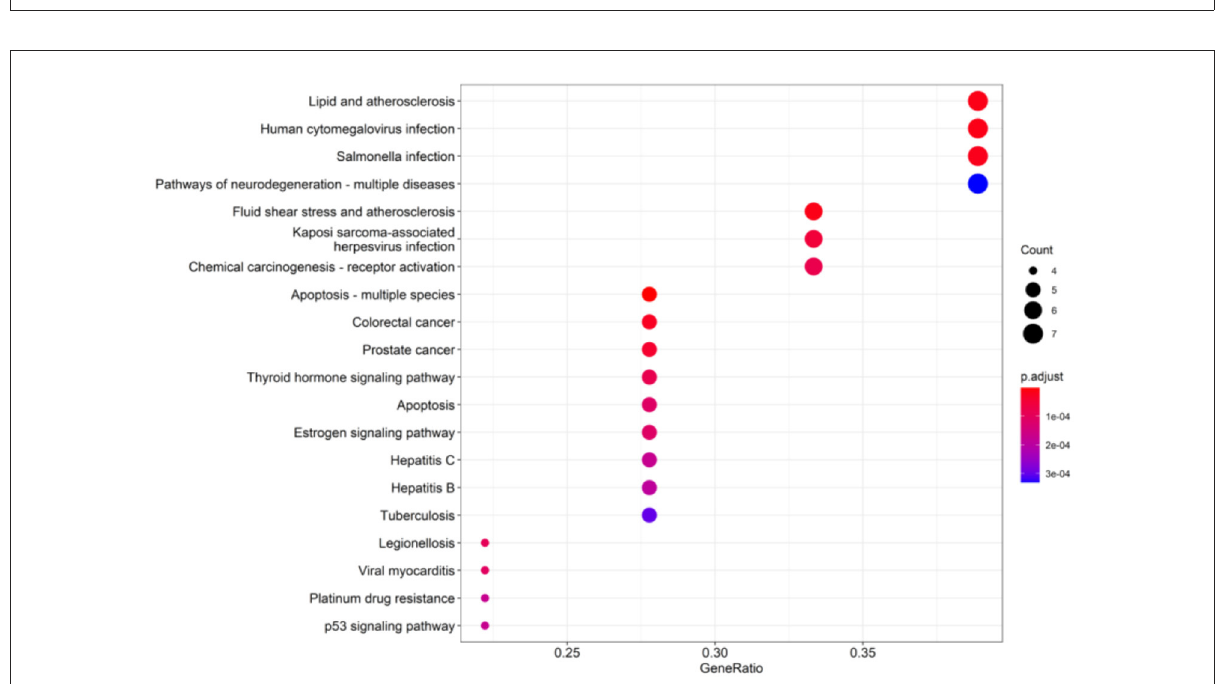
functional evaluation of food ingredients and the development of functional foods. In future studies, the antioxidant efficacy and biological mechanisms of β -carotene and vitexin from mung bean will be investigated with more in vivo / in vitro experimental